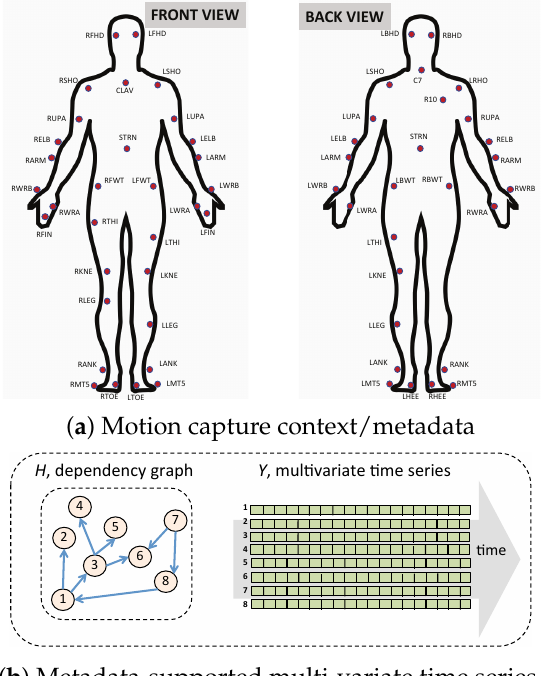
Figure 3. ( a ) Motion capture involves capturing the positions of multiple sensors placed on the human body (the positioning of the sensors are taken from [10]); ( b ) consequently, the resulting multi-variate time series needs to be interpreted within the context of the metadata describing the relationships among the sensor